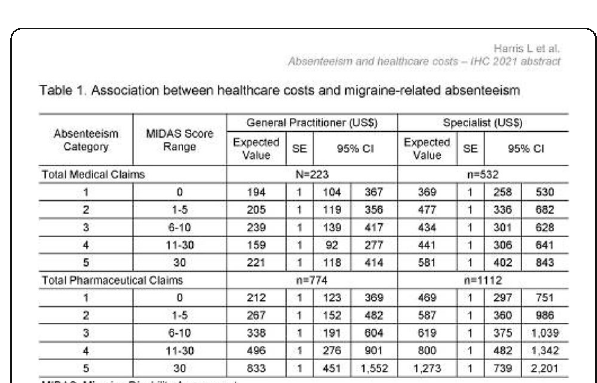
Table 1 (abstract AL014). See text for